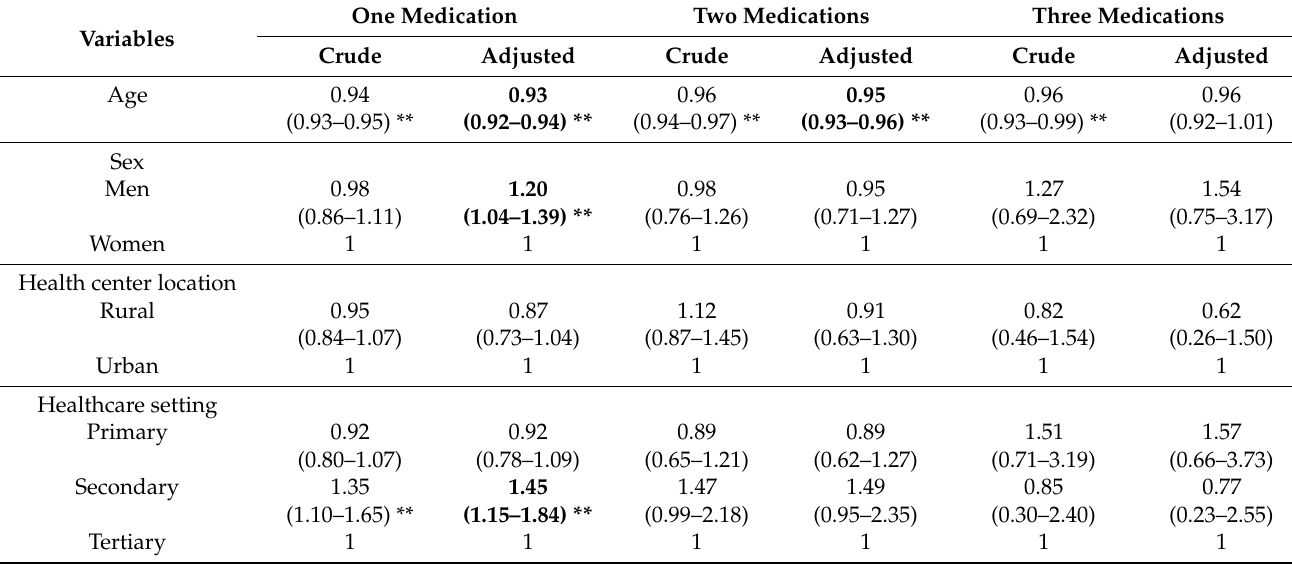
Figure 3. Medication adherence to different classes of drugs during the first 6-months of antihypertensive treatment initiation. ACEi: angiotensin-convertase enzyme inhibitor, ARB: angiotensin-receptor blockers, CCB: calcium channel blockers, BB: beta-blockers, DU: diuretics. Table 4. Factors associated with adherence to antihypertensive